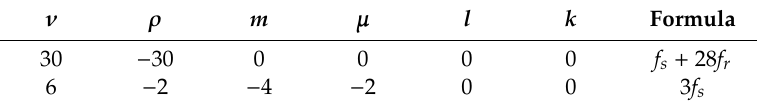
Table 3. Harmonic orders and formulas for the symmetry case.